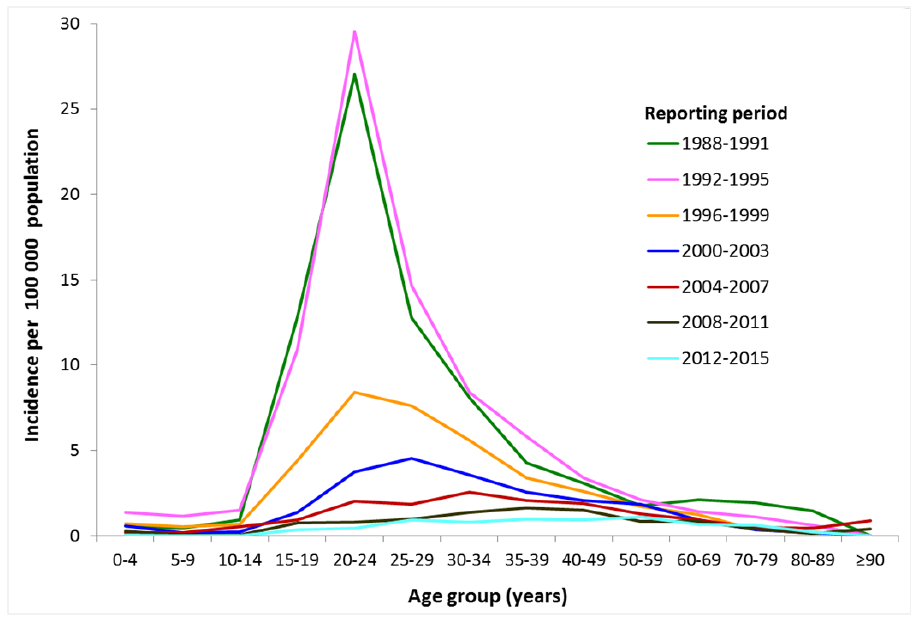
Figure 3: Incidence rate of acute hepatitis B virus infection by age and notification period, Switzerland, 1988–2015.